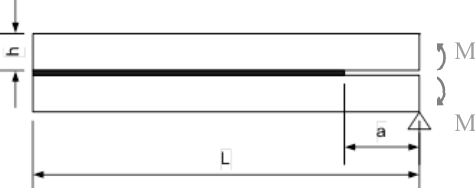
Figure 5. Joint geometry of simulations. Dimensions: a 0 = 30mm; h = 5 mm; L = 335 mm; M = 300 Nmm/mm. Table 1. Cohesive zone model (CZM) and fatigue crack growth (FCG) parameters that are not varied in the simulations, from 21.